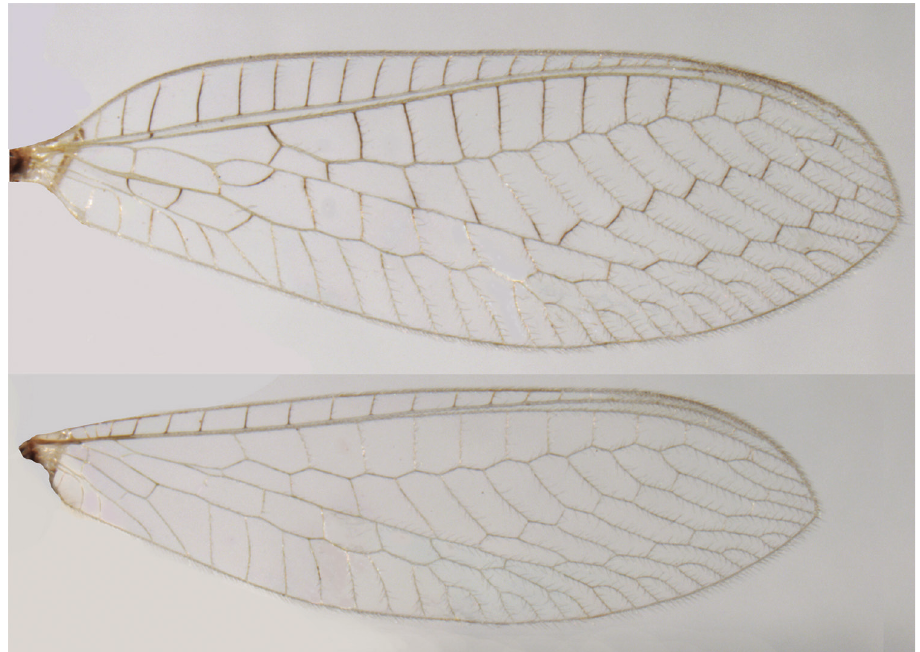
Figure 6. Ungla adamsi Tauber, sp. n. Wings (Peru, Machu Picchu, paratype, female, FSCA).